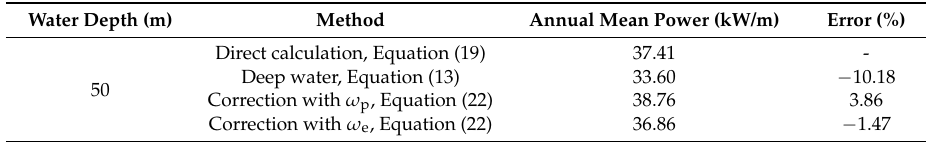
Table 2. Wave power assessment for